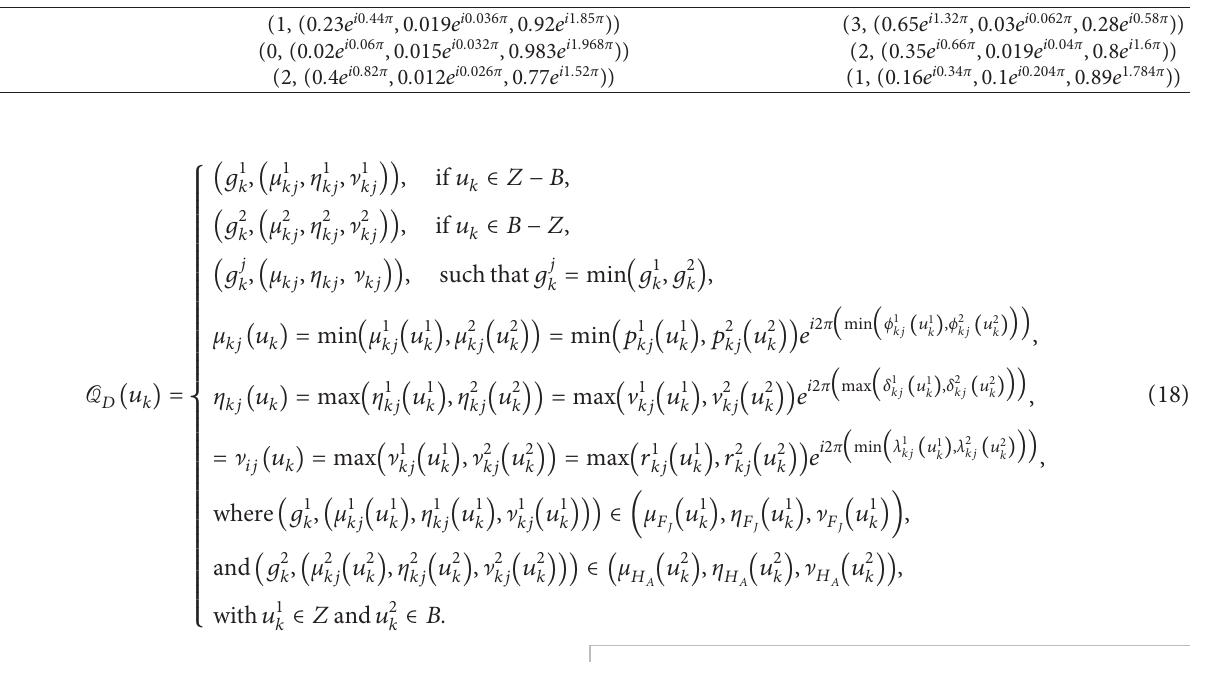
Table 11: Tabular representation of CSF 6 S